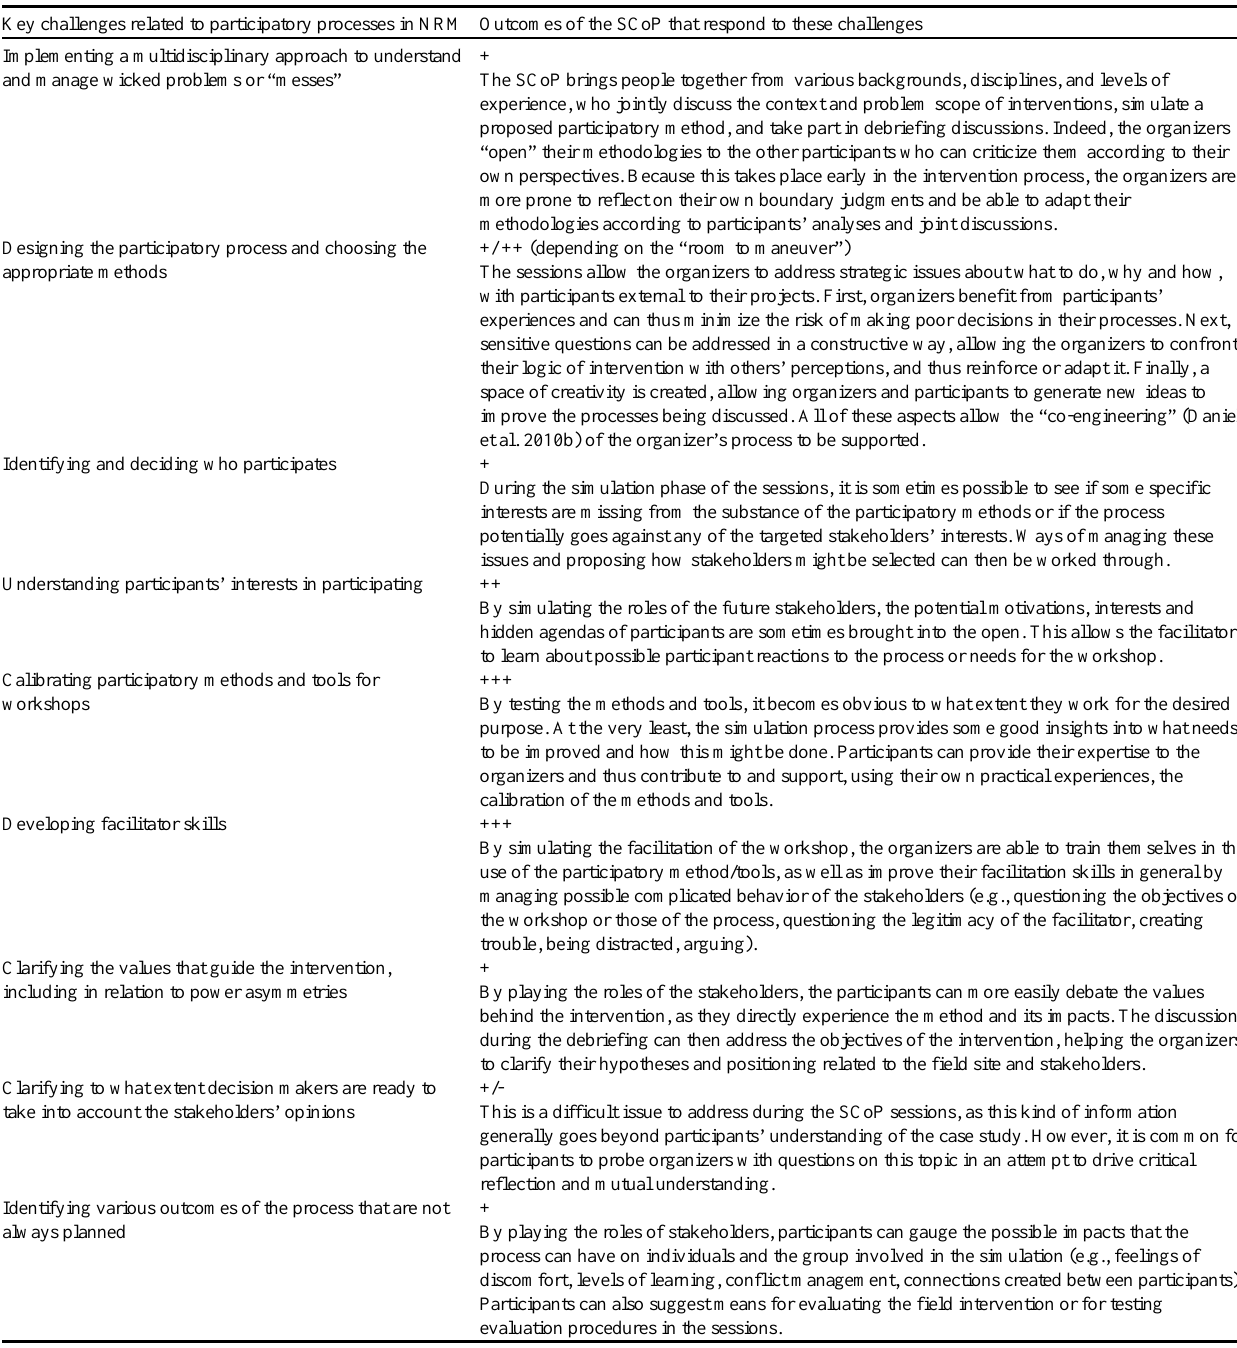
Table 2 Evaluation of the SCoP’s impact related to the challenges of participatory processes in NRM. To what extent this SCoP helps to produce specified outcomes that respond to these challenges are interpreted as follows: +++ = great impact; ++ = reasonable impact; + = little impact; +/- = no discernible